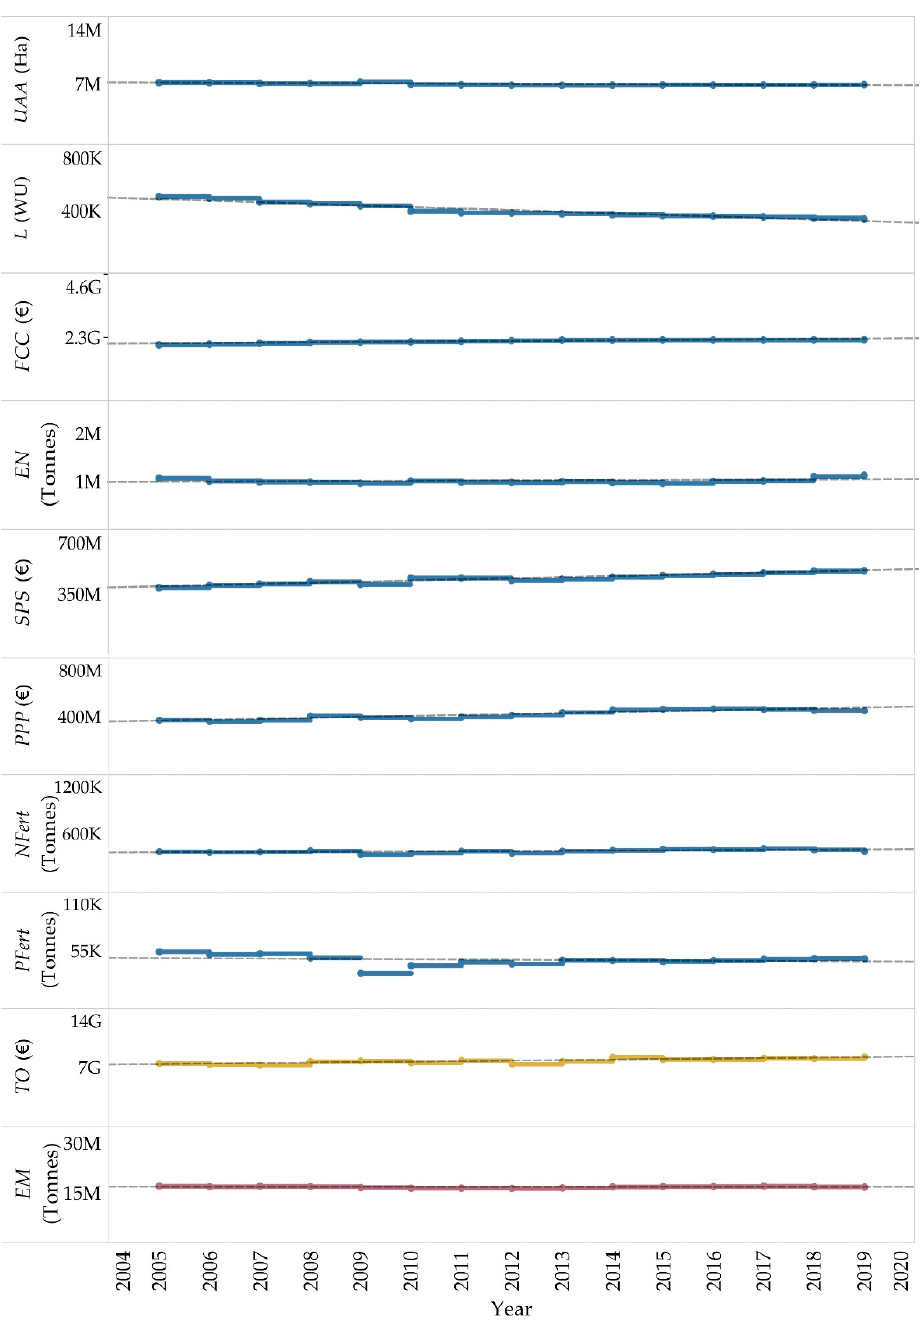
Figure 3. Average valuets of Inputs and Outputs for reference period 2005–2022.